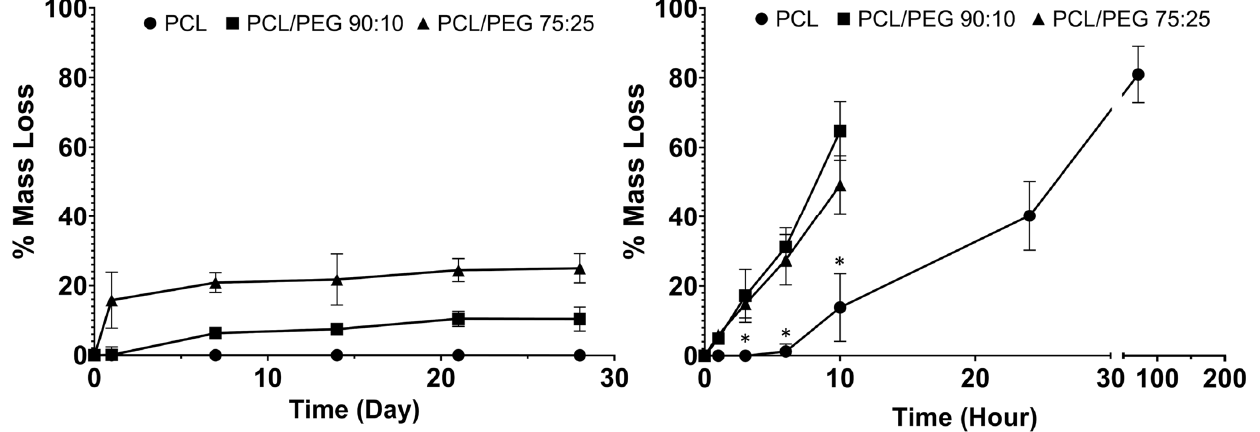
Figure 2. Physiological degradation (10 mL PBS at 37 °C) of PCL and PCL/PEG meshes (left). Accelerated degradation (10 mL 5 M NaOH at 37 °C) of PCL and PCL/PEG meshes (right). * shows significant less mass loss % in the PCL meshes compared to both PCL/PEG groups ( n = 3, p < 0.05).